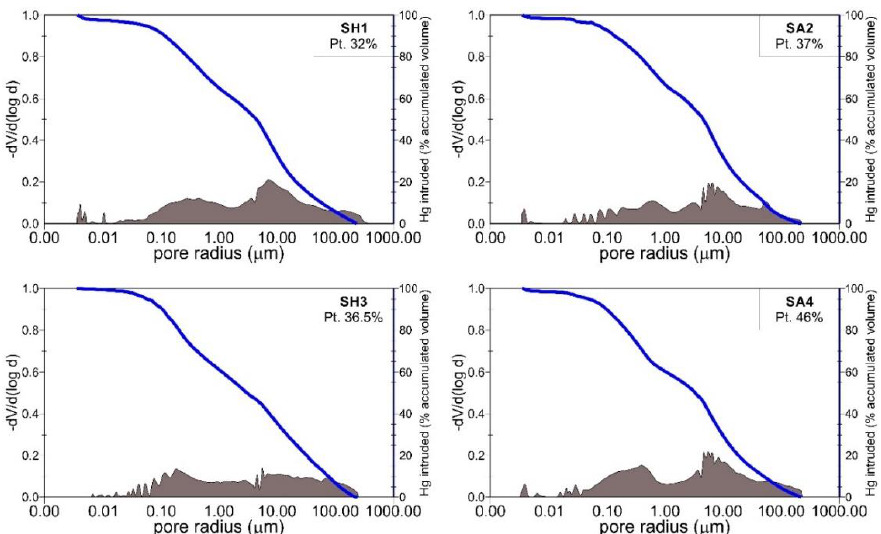
Figure 6. Porosimetric values of the samples studied. The relative volume of intruded Hg is shown in brown. The blue path represents the accumulated volume of intruded Hg (Pt = total porosity). The percentage of pores in the macropore radius range (r) between 1000–100 µ m in anaerobic wet-conserved hemp (A) is half that in freshly harvested hemp (H). In all